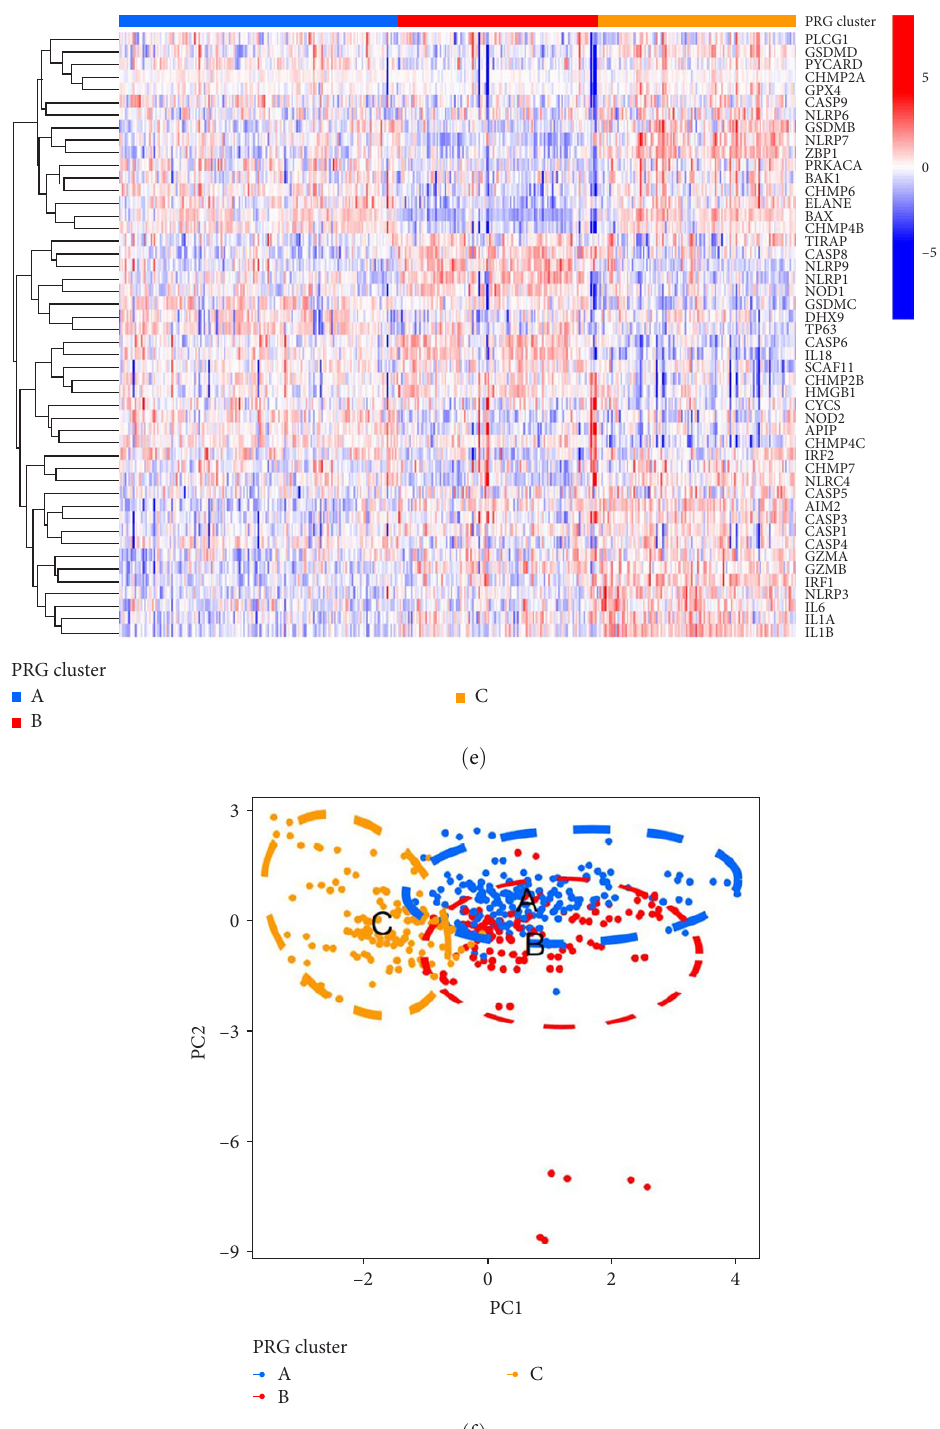
ð f Þ F IGURE 6: Consensus clustering of the 48 distinct PRGs in periodontitis. (a) Consensus matrices of the 48 distinct PRGs for k =3. (b) CDF for k =2 – 9. (c) Relative change in area under CDF curve for k =2 – 9. (d) Differential expression levels of the 48 distinct PRGs in three PRG patterns. (e) Expression heat map of the 48 signi fi cant PRGs in three PRG patterns. (f) PCA for the expression pro fi les of the three PRG patterns. ∗ p < 0 : 05, ∗∗ p < 0 : 01, and ∗∗∗ p < 0 : 001. PRG, pyroptosis-related gene; CDF, cumulative distribution function; PCA, principal component